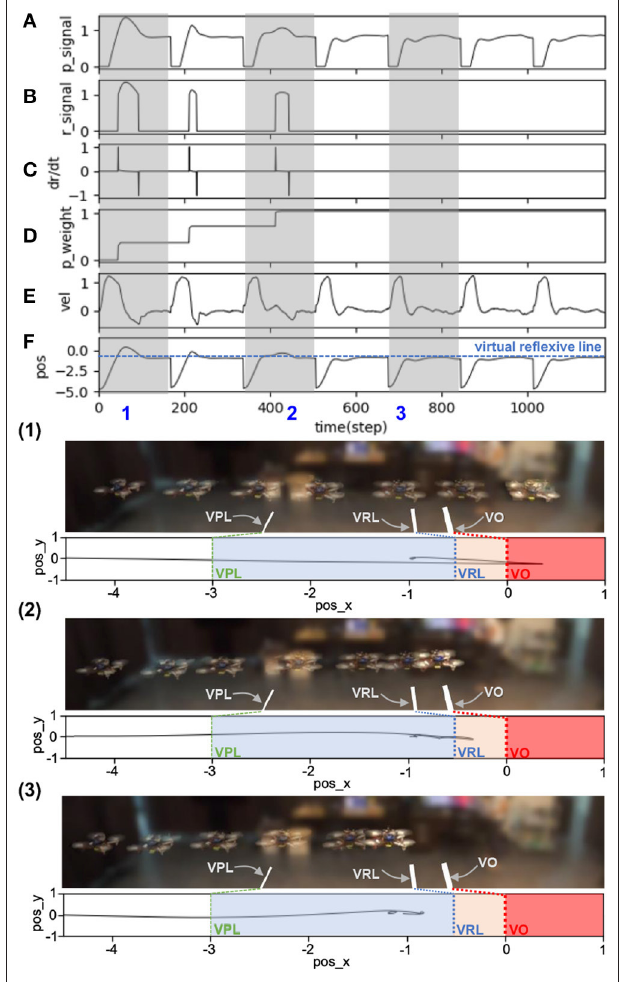
FIGURE B1 | Real-time data of speed adaptation during online learning while flying the UAV at a maximum speed of 1.0 m/s. (A) Predictive signal. (B) Reflexive signal. (C) Derivative of the reflexive signal. (D) Predictive weight. (E) Actual speed (x-axis) of the UAV. (F) Position on the x-axis of the UAV compared to the virtual reflexive line (blue line). The gray areas represent three periods and show the UAV’s position with respect to the virtual predictive line (VPL), virtual reflexive line (VRL), and virtual obstacle (VO). These three periods are shown in the three snapshots together with the corresponding estimated trajectories (1, 2, 3) namely the beginning of learning (1), during learning (2), and after learning (3).